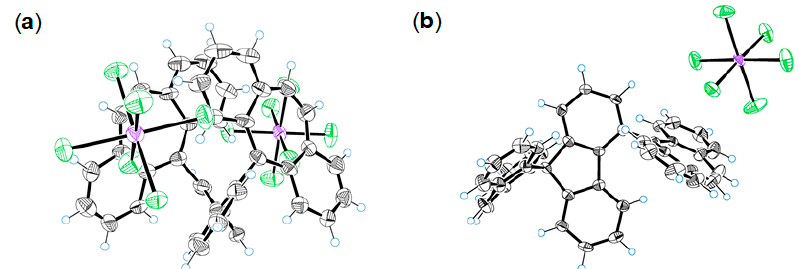
Figure 9. ORTEP drawings of ( a ) 2 2+ (SbCl 6 − ) 2 · 2(CH 2 Cl 2 ) and ( b ) 8 + (SbCl 6 − ) · (CH 3 CN) at 150 K. Solvent molecules are omitted for clarity and thermal ellipsoids are shown at the 50% probability level.